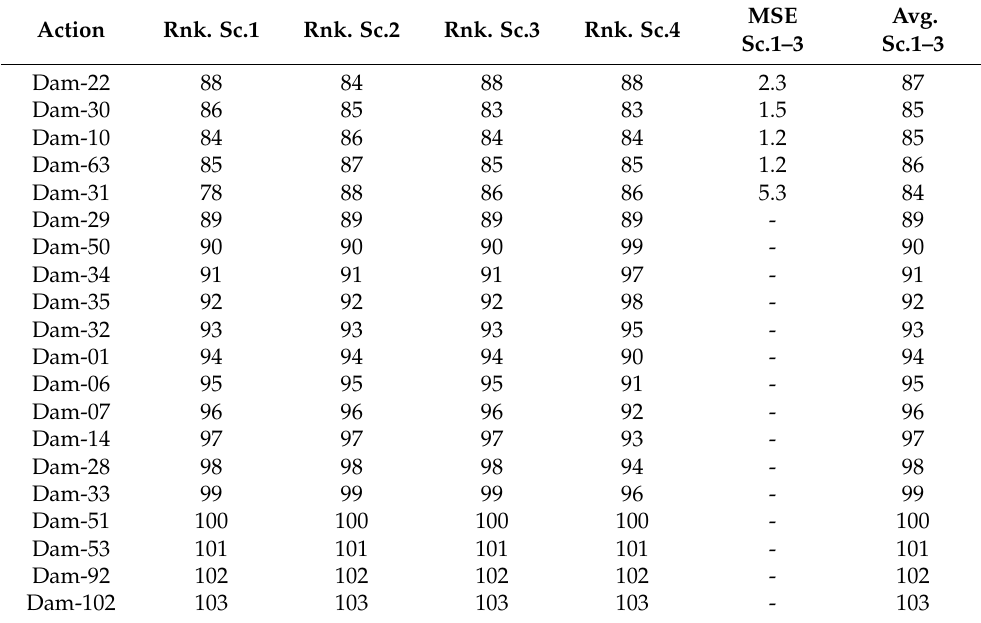
Table A3. Rank position comparison for the scenarios (last